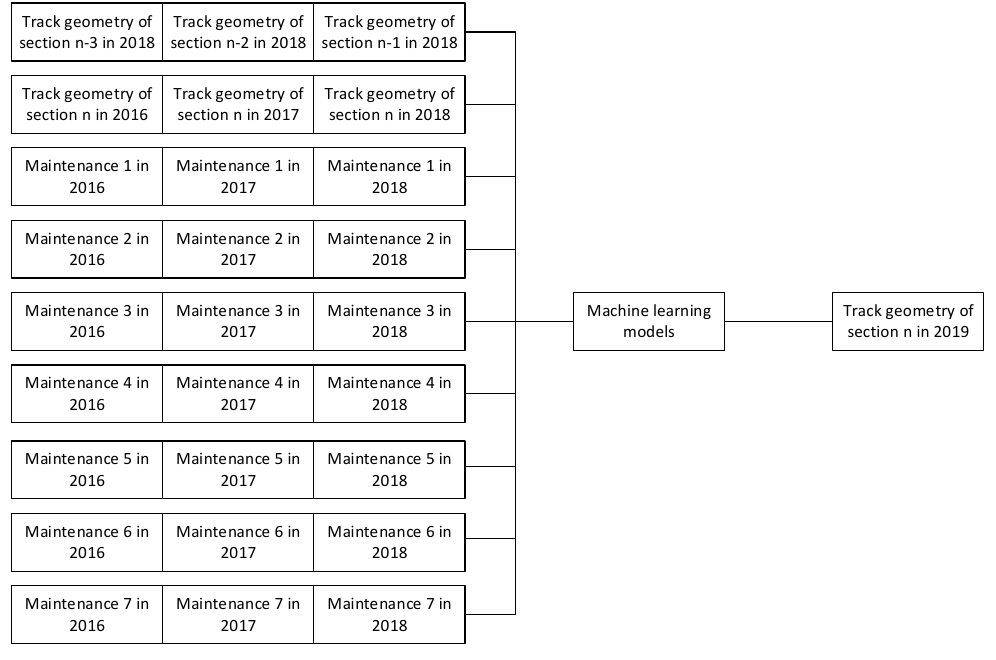
Figure 1. Inputs of machine learning models.